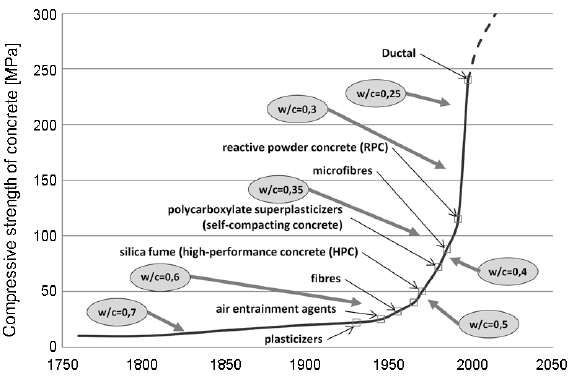
Fig. 12. Curve of concrete evolution (Czarnecki